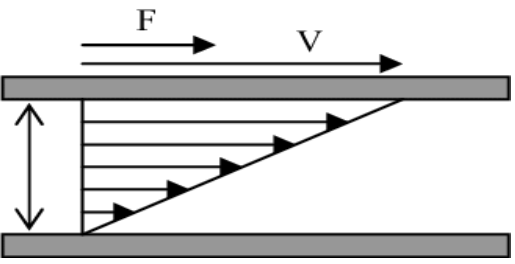
Figure 9. Shear between two parallel flat plates: one is fixed and the other is mobile.